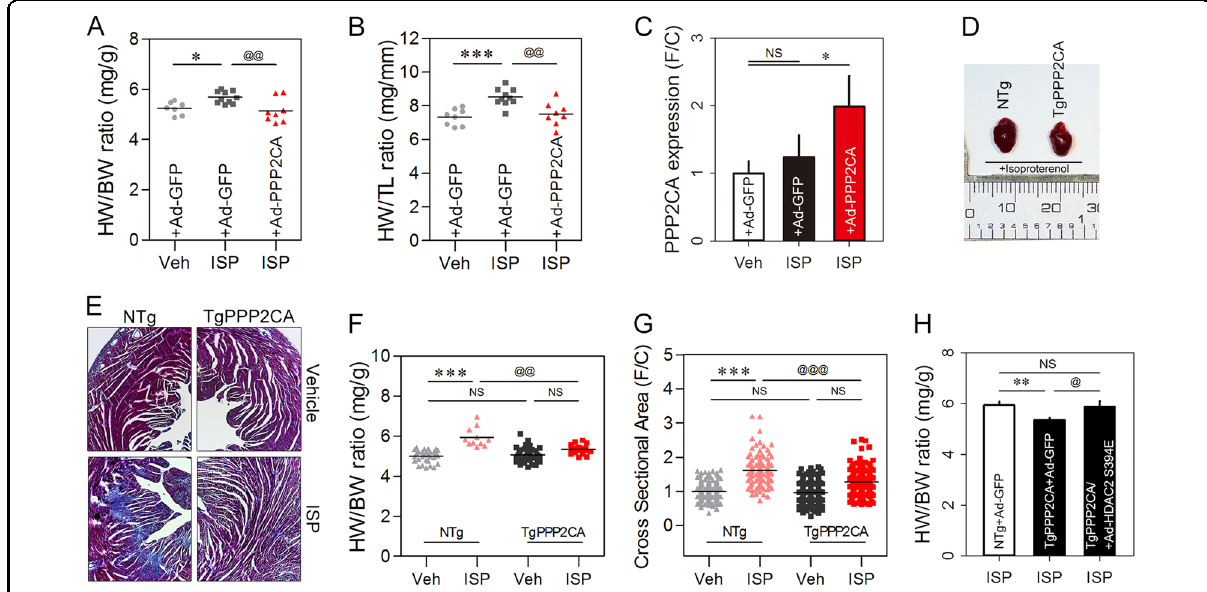
Fig. 7 PPP2CA negatively regulates cardiac hypertrophy through HDAC2 dephosphorylation in the heart. a , b The anti-hypertrophic effect of PPP2CA was tested in CD1 mice. An in vivo hypertrophy model was tested using ISP infusion. Ad-PPP2CA was delivered via the tail vein 7 days after implantation of an ISP micro-osmotic pump, and the mice were sacri fi ced 14 days after the operation. Simultaneous expression of PPP2CA blunted ISP-induced cardiac hypertrophy, as determined either by heart weight per body weight ratio (HW/BW) ( a ) or by heart weight per tibia length ratio (HW/TL) ( b ). Dots depict individual mouse data. The mouse numbers used in a and b are as follows: 7 (Sham + Ad-GFP), 10 (ISP + Ad-GFP), and 8 (ISP + Ad-PPP2CA). c Quantitative real-time PCR revealed that Ad-PPP2CA successfully infected the myocardium. d Representative gross images. e – g Cardiac hypertrophy was signi fi cantly attenuated in TgPPP2CA mouse heart. Masson ’ s trichrome staining. Interstitial fi brosis induced by ISP infusion was dramatically reduced in TgPPP2CA mice ( e ). Transgenic expression of PPP2CA allowed resistance against the hypertrophy stimulus induced by infusion of ISP ( f ). Cross-sectional area in the left ventricle free wall showed a pattern similar to the HW/BW or HW/TL results ( g ). The anti-hypertrophic effect of PPP2CA against ISP infusion was not observed when Ad-HDAC2 S394E was expressed simultaneously in the heart of TgPPP2CA mice (H). * and @ depict p < 0.05. ** and @@ indicate p < 0.01. *** and @@@ mean p < 0.001. NS not signi fi cant